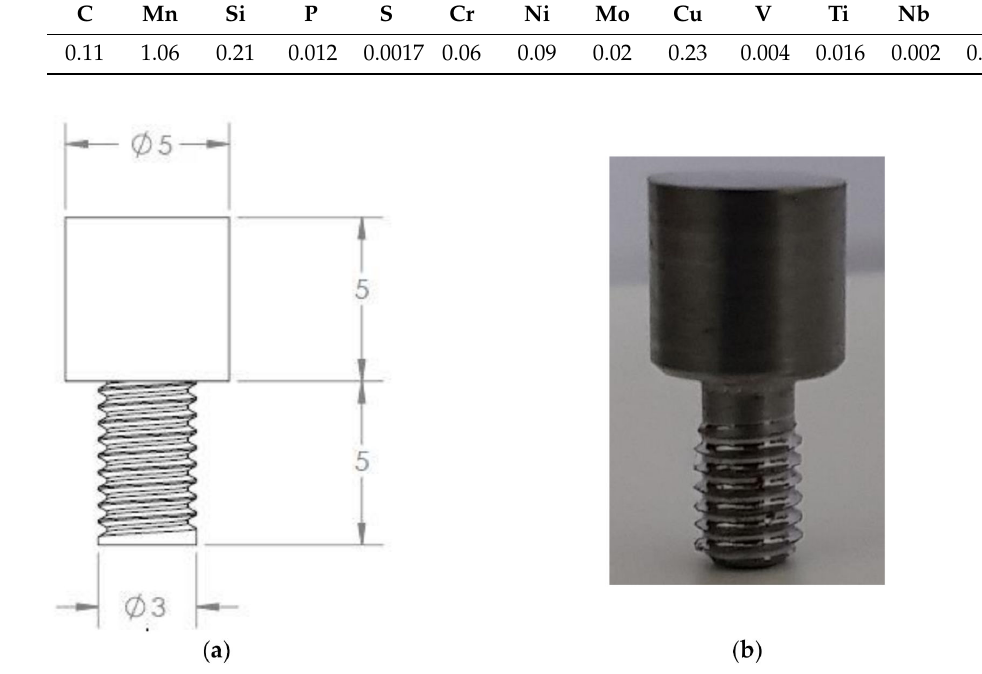
Figure 1. API 5L X65 specimen for corrosion testing ( a ) CAD Model, ( b ) actual